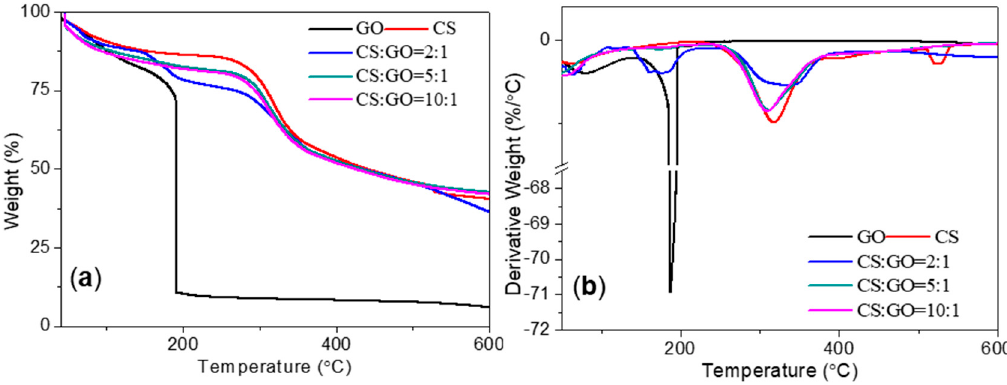
Figure 7. ( a ) Thermogravimetric analyses (TGA) and ( b ) derivative thermogravimetry (DTG) for GO, CS, and CS:GO